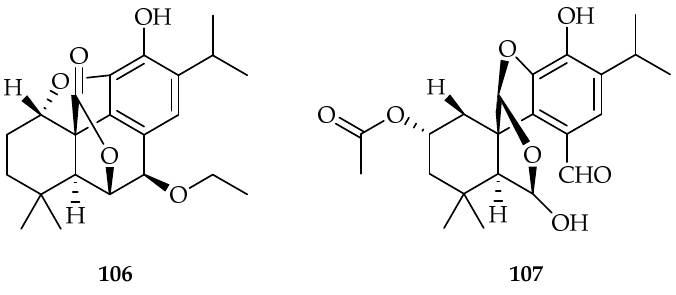
Figure 44. Structures of compounds 106 and 107 [67].